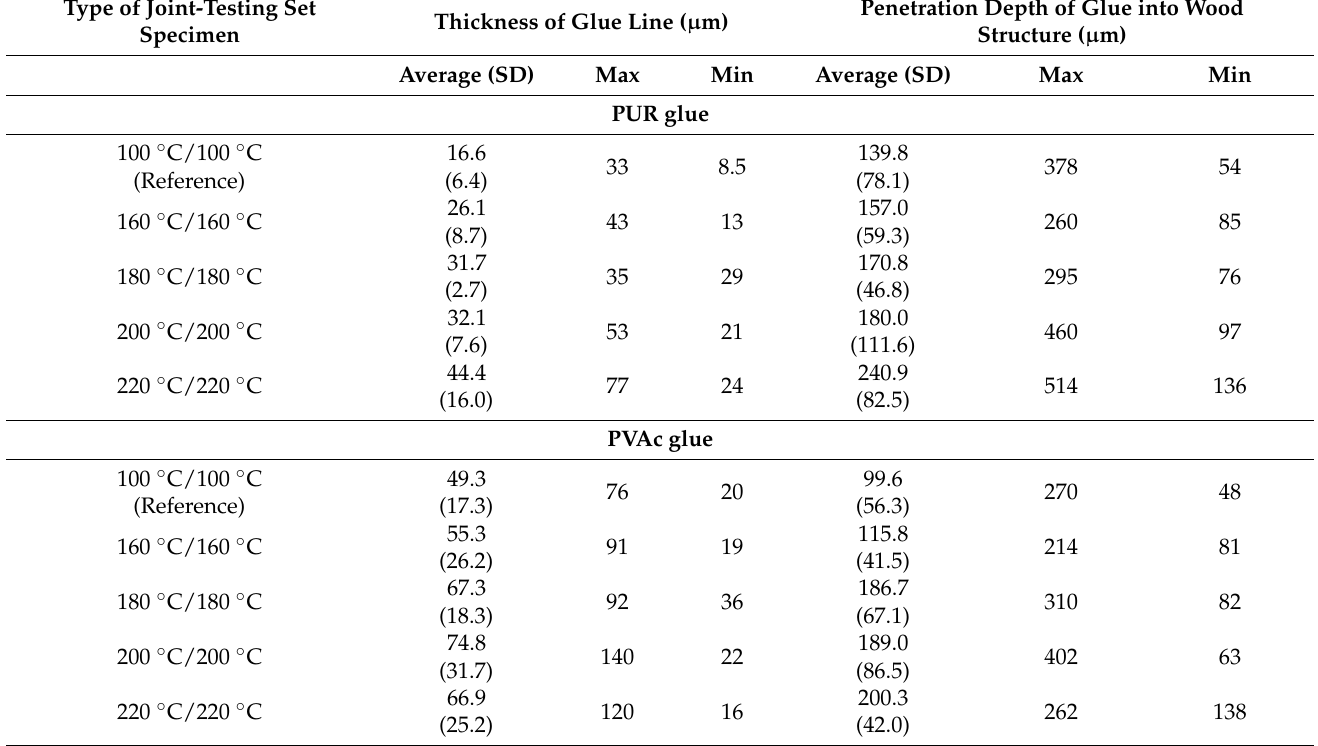
Table 2. The thickness of glue line and the penetration depth of PUR and PVAc glues into the structure of reference and thermally modified spruce wood